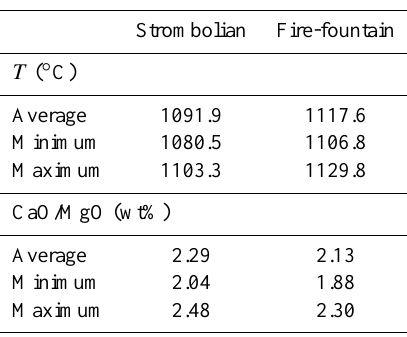
Table 2. Eruptive temperatures and CaO/MgO content in products from explosive activity at Etna in 2000.